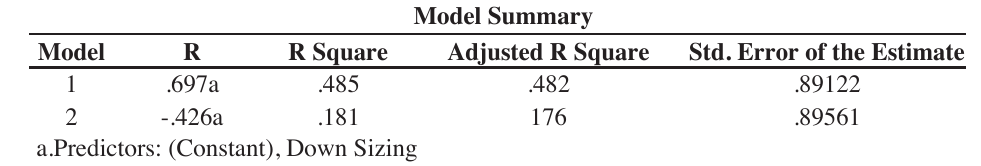
Regression Model